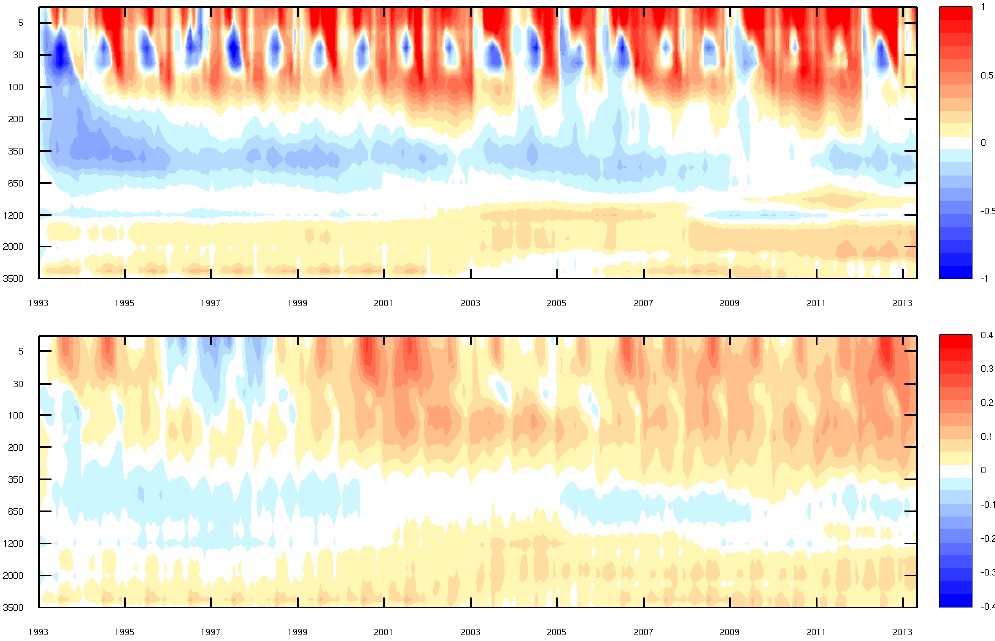
Figure 11. MEDRYS basin mean temperature ( ◦ C, above) and salinity (psu, below) anomalies with respect to